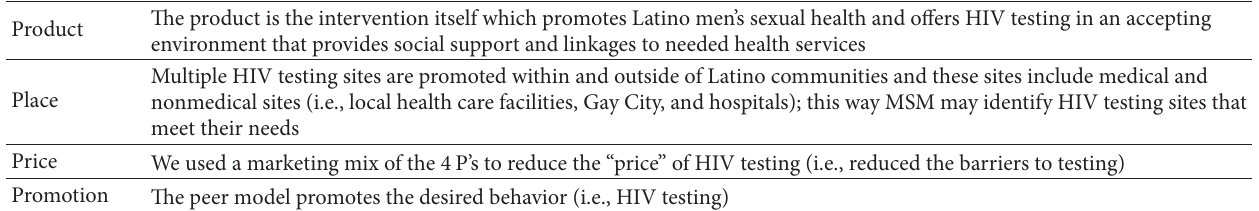
Table 2: Application of marketing principles: the 4P’s (product, place, price, and promotion).